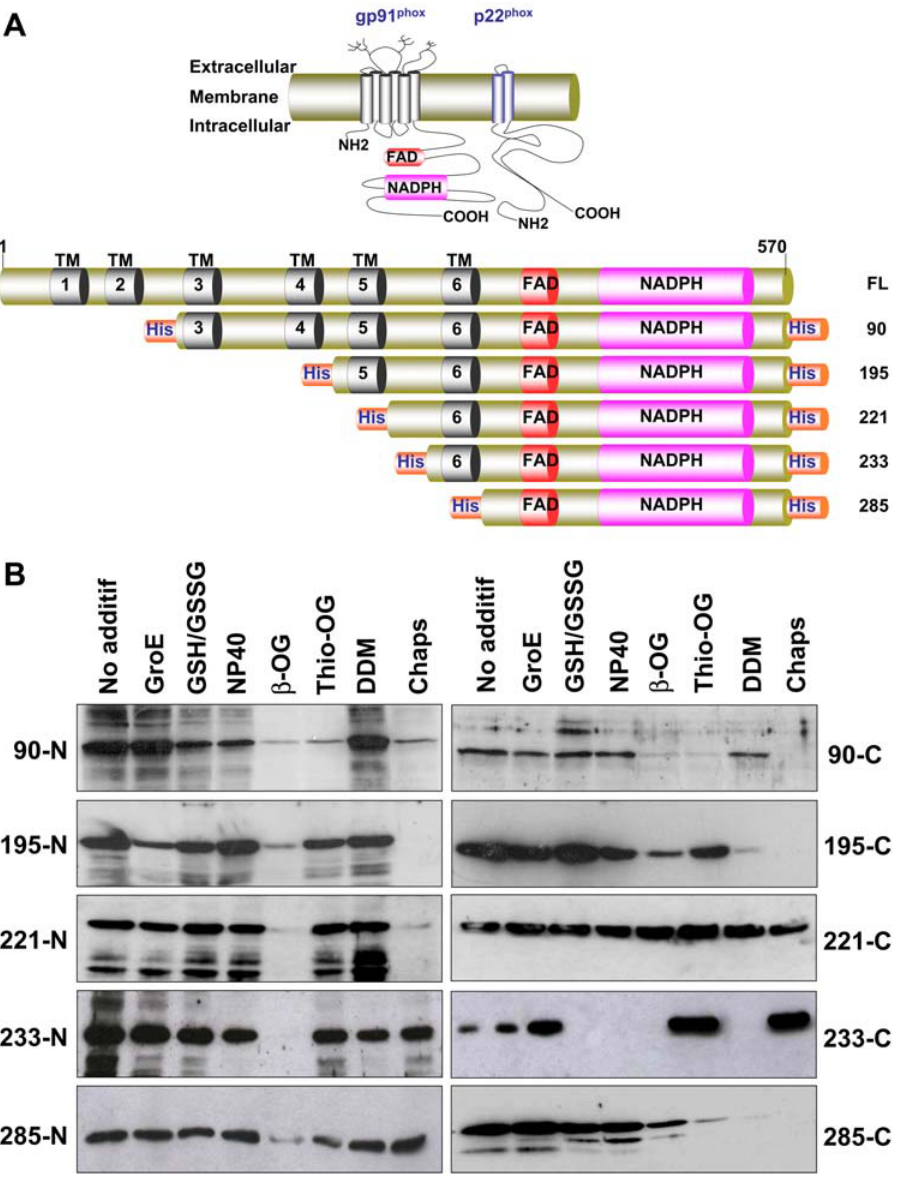
Figure 2. Expression of truncated gp91 phox proteins. (A) Schematic representation of the phagocyte NADPH oxydase and truncated forms gp91 phox expressed in a bacterial cell-free translation system. Gp91 phox full-length (FL) is presented at the top of the diagram: transmembrane domains are shown in black. FAD and NADPH binding-sites are represented in red and pink respectively. Truncated gp91 phox were designed with a his-tag located either at the N or at the C terminal part of the protein. (B) Analysis of the expression of the ten gp91 phox truncated proteins by western blot using a monoclonal antibody anti-his.